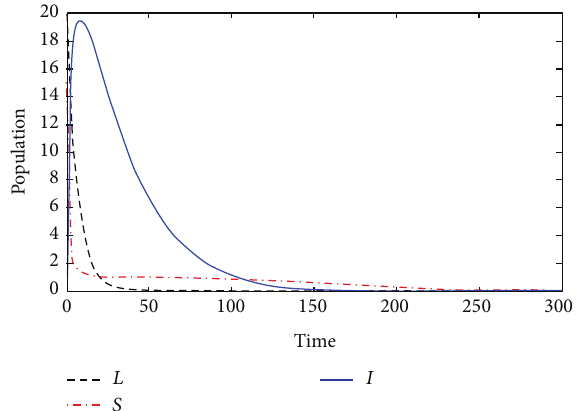
Figure 1: This figure shows the time series of model (1) when R 0 < 1 . It is clear that all the population will extinct in this case. The parameters used are 𝛽 = 0.002; 𝜇 = 0.05; ] = 0.02; 𝜌 = 0.1; 𝜎 = 0.001; 𝛼 = 0.01 .